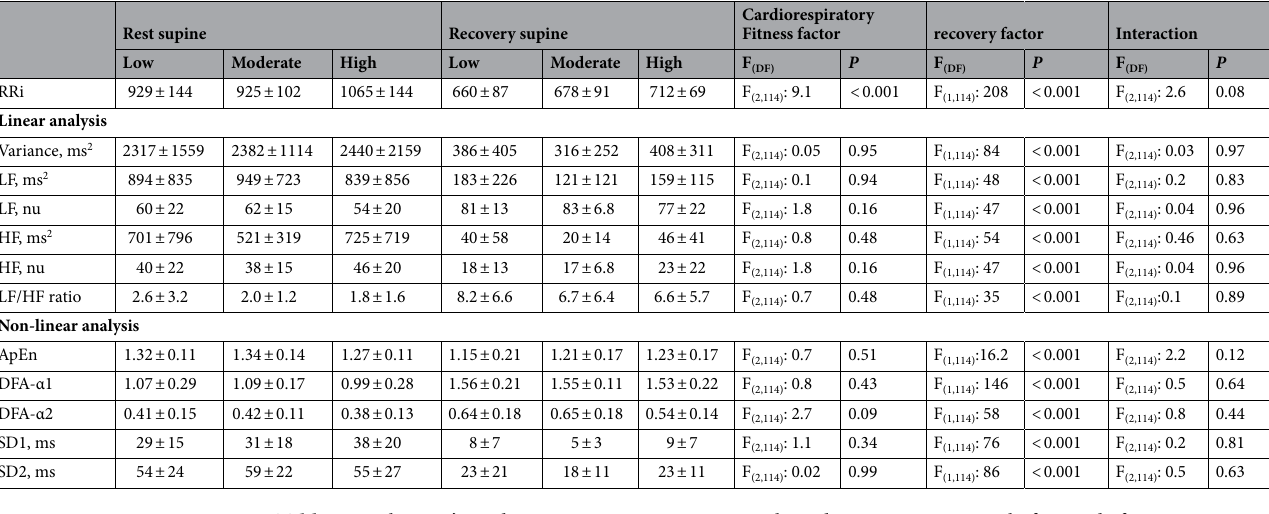
Table 3. Volunteer’s cardiac autonomic parameters evaluated at supine positions before and after cardiopulmonary test. Data are presented as mean ± SD. RRi R–R intervals of ECG, ms milliseconds, LF low- frequency band, HF high frequency band, nu normalized units, ApEn approximate entropy, DFA detrended fluctuation analysis, SD1 standard deviation of instantaneous beat-to-beat interval variability, SD2 standard deviation of continuous long-term R–R interval variability, F factor, DF degrees of freedom.